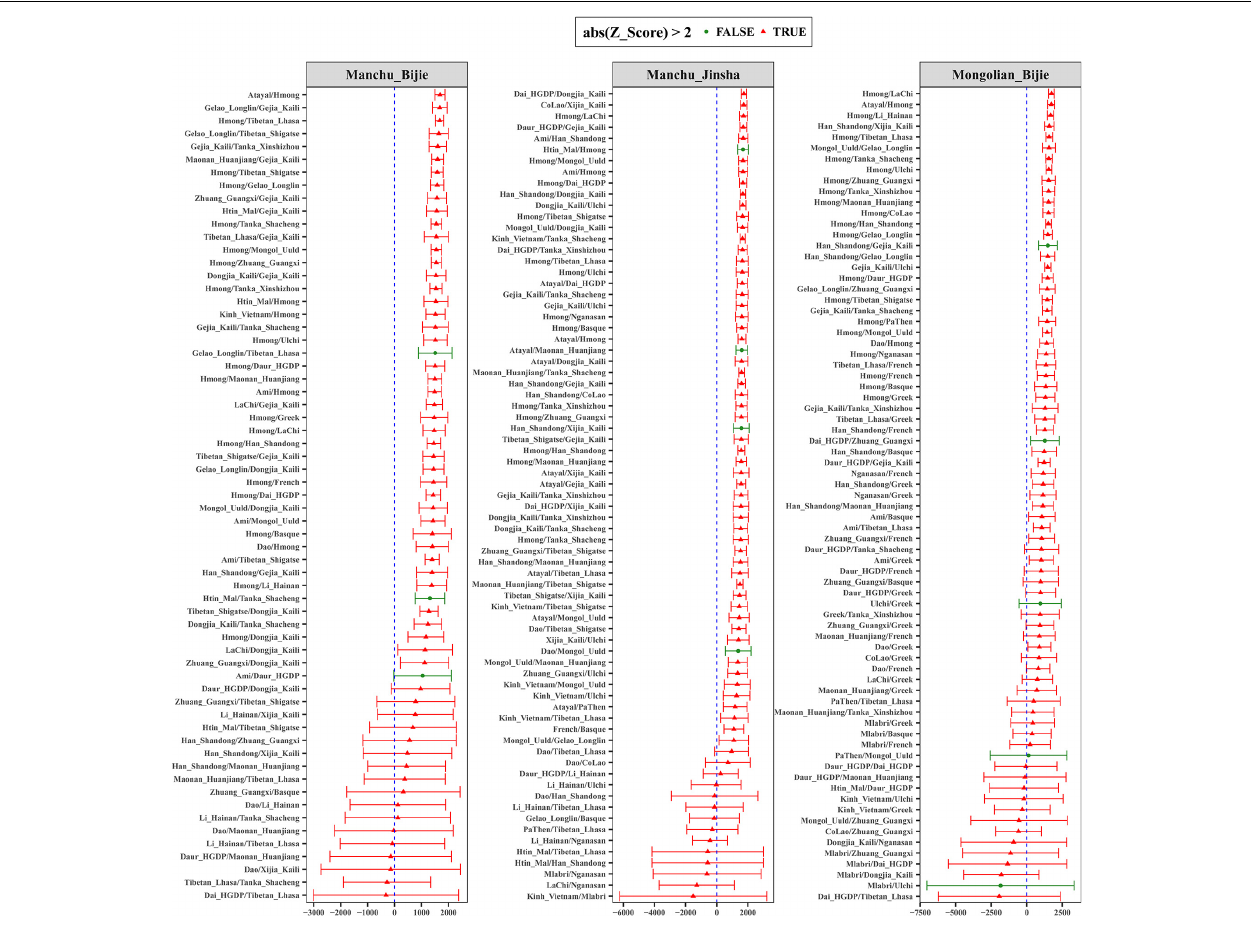
FIGURE 6 | ALDER-based admixture time with different ancestral sources. The length of 29 years of one generation was used.